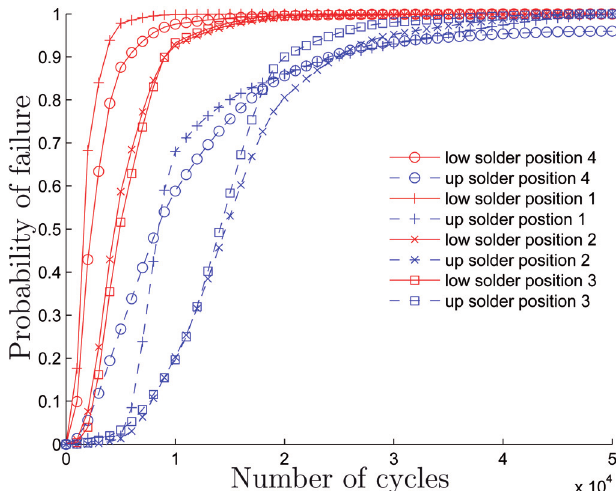
Fig. 8. Elasticities of the random variable’s standard devia- tion for different solder